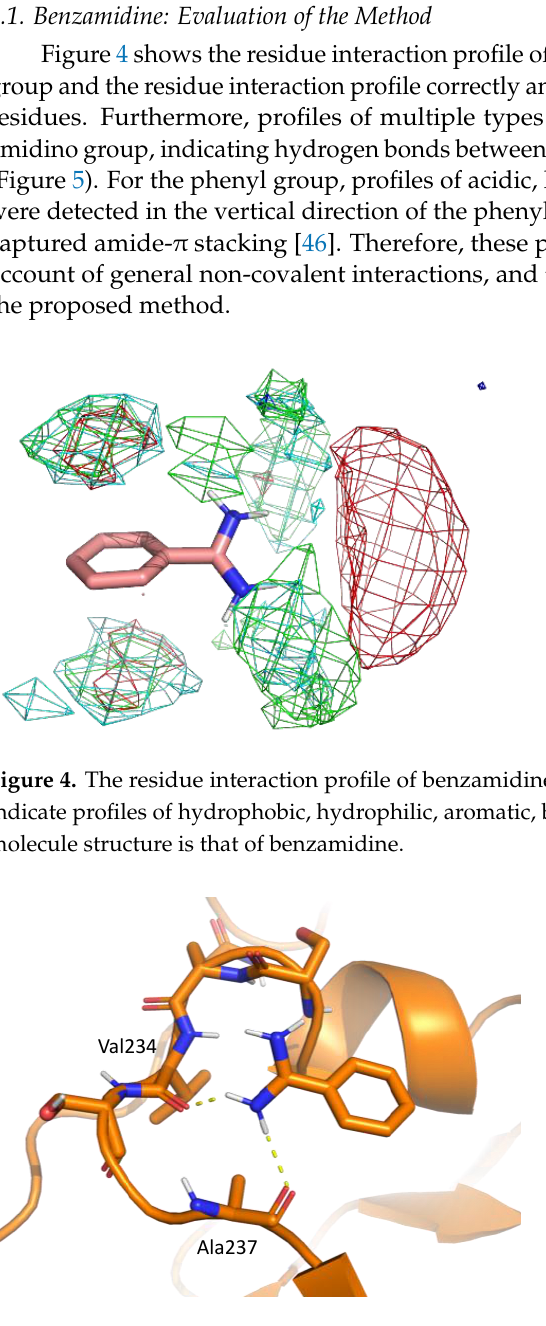
Figure 5. An example of interaction pattern between benzamidine and penicillopepsin (PDBID: 2WEA) obtained from MSMD simulation. Yellow hashed lines show hydrogen bonds.